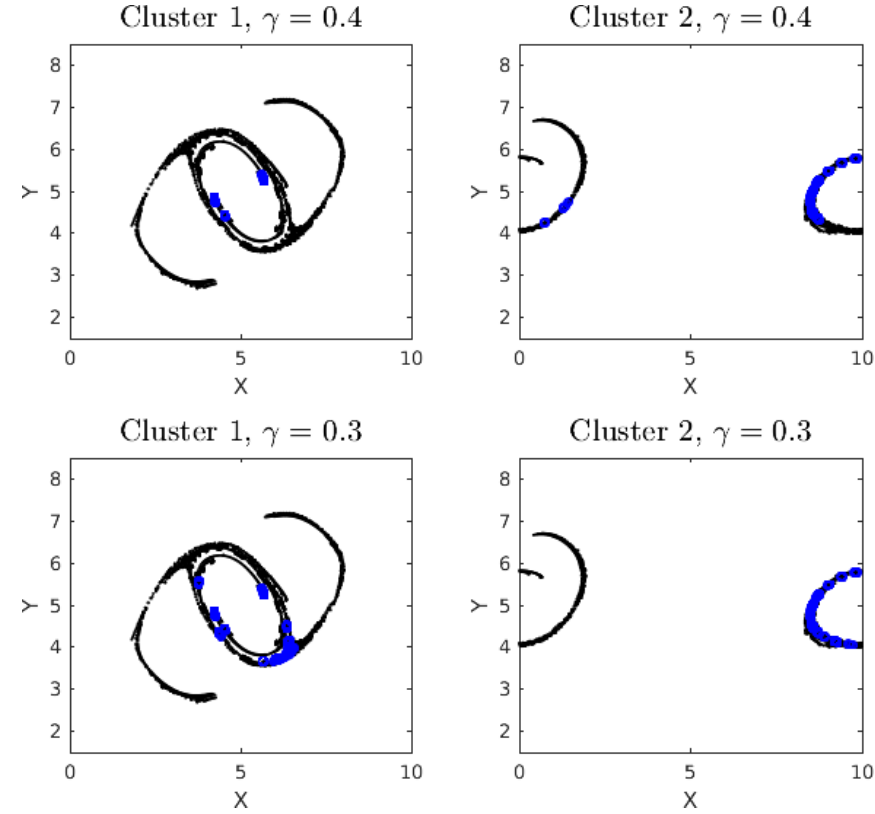
Figure 11. Dense clusters with (cid:15) = 60% in cumulative clusters 1 and 2 at t = 50.